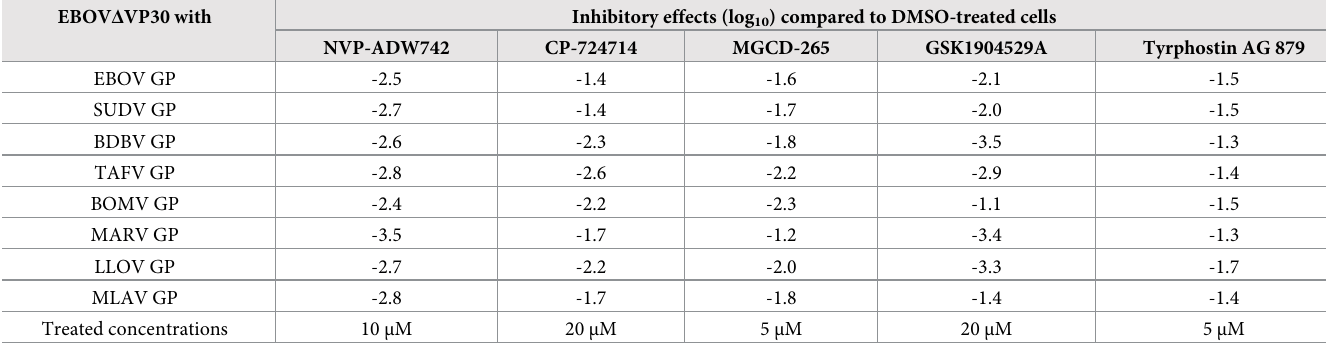
Table 2. Effects of selected compounds on filovirus GP-mediated infection.